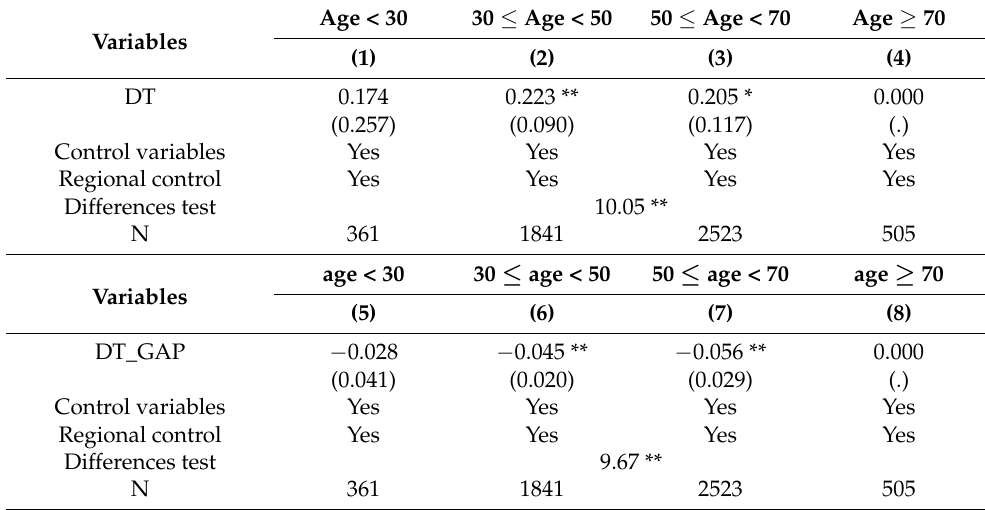
Table 9. Age of householder heterogeneity: test results of the impact of DT & DT_GAP on LRB. Variables